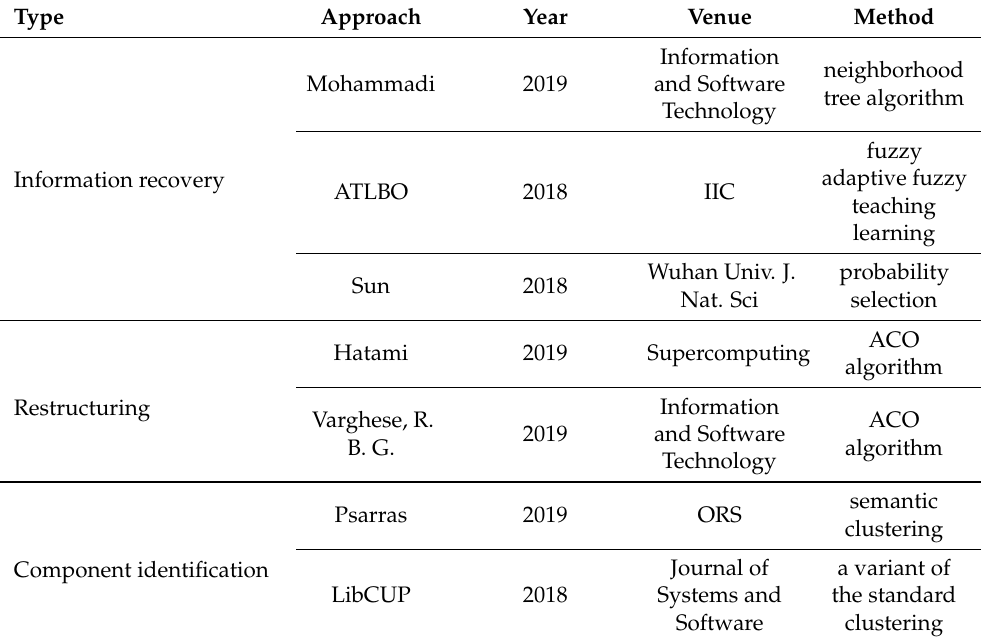
Table 1. Applications of software modularization. Type